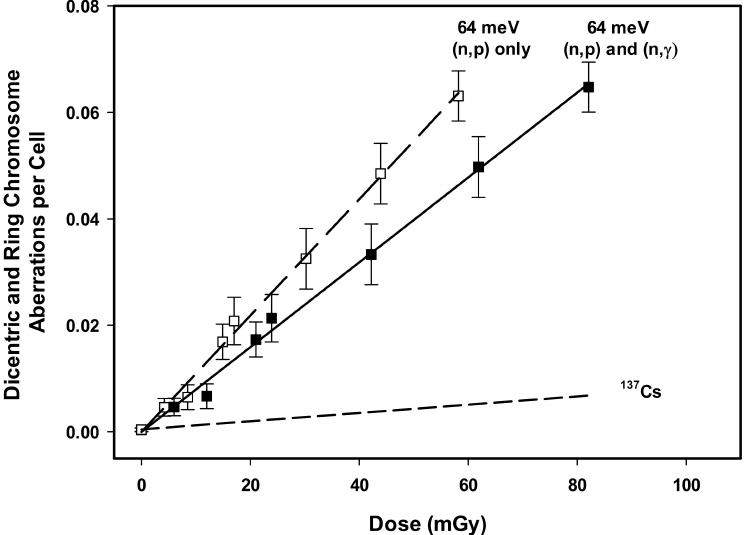
Figure 2. DCA linear dose response regression for the 64 meV neutron exposures ((n,p) and (n, γ ), filled squares and solid line; only the (n,p) reaction, open squares and long-dash line), compared to the extrapolated 137 Cs curve (short-dash line) from the linear-quadratic dose response derived by Flegal et al. [21]. The graph details the relationship between radiation dose and the number of dicentric and centric ring chromosome aberrations per cell. Error bars represent standard error of the mean across three